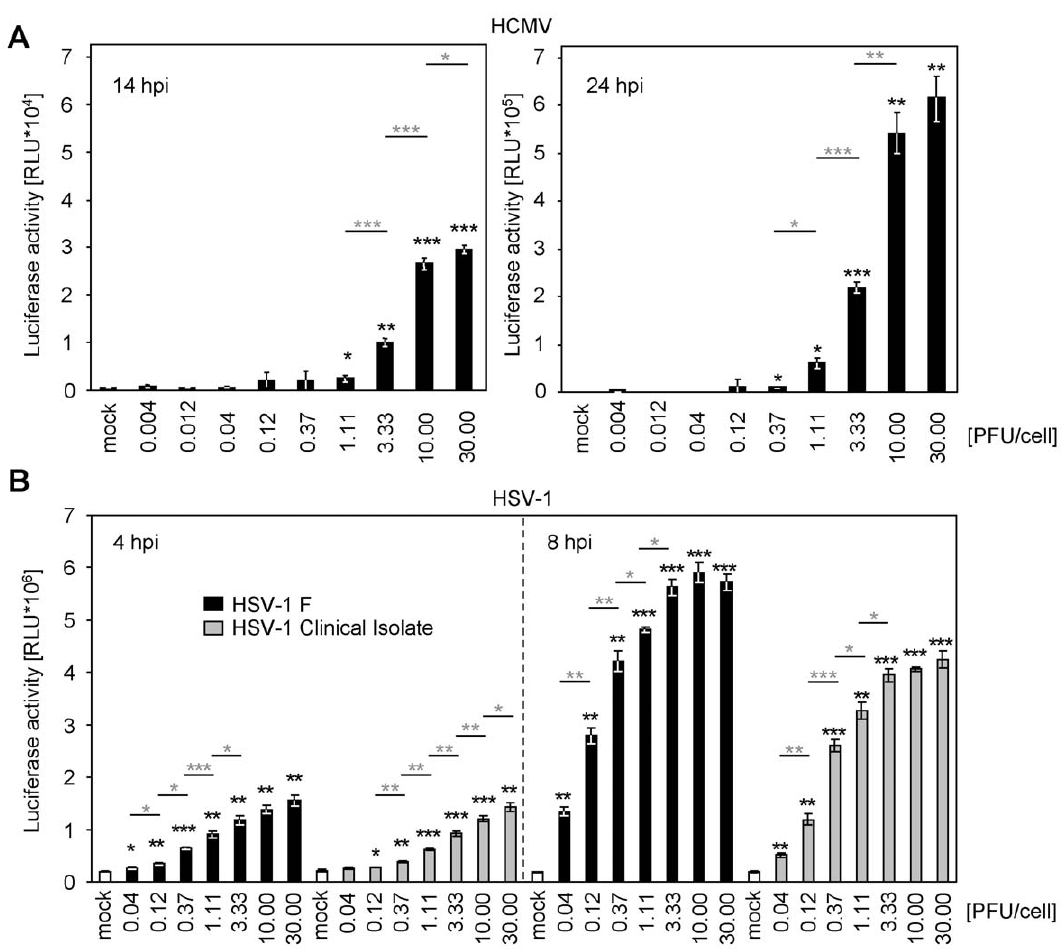
Figure 6. pTA-Control is transactivated upon herpesvirus infection in a virus dose-dependent manner. ( A ) WI-38 cells were transiently transfected (nucleofection) with the pTA-Control plasmid. Cells were infected for 14 h (left panel) or 24 h (right panel) with indicated PFU/cell HCMV- TB40/E. Cells were lysed and luciferase activity was measured. The arithmetic mean of triplicates 6 standard deviation (SD) is shown. Statistical significance was tested by unpaired two-sided t-test with unequal variance compared to the mock (black asterisks) and the corresponding lower infectious dose (depicted in grey). * p , 0.05; **p , 0.01 and *** p , 0.001. Please note the different scale between left (*10 4 ) and right (*10 5 ) panel. ( B ) As in ( A ) but HeLa cells were nucleofected with pB45Neo-promLUC and infected with the indicated infectious dose of HSV-1 F strain (black bars) or a low-passage clinical HSV-1 isolate (grey bars). Arithmetic mean of triplicates 6 SD is shown. p-values as in (A).